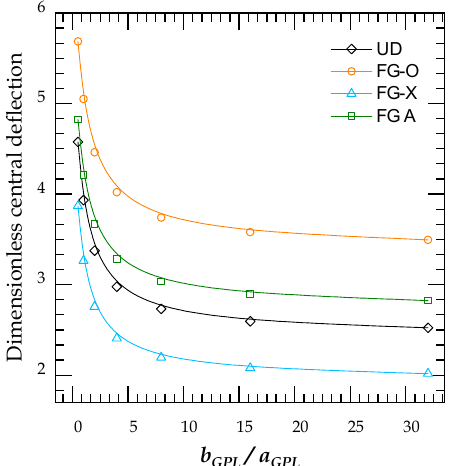
Figure 11. Dimensionless central deflection of simply supported GRNC plate versus the length-to- thickness ratio of the GPLs nanofillers (g ∗ = 1%) . Figure 12 depicts the dimensionless central deflection influenced by width-to-length ratio b GPL / a GPL . It can be observed that the width-to-length ratio has a significant effect on the dimensionless central deflection for values less than 15, where central deflection decreases. The results are almost constant for greater values of ratio ( ≥ 15 ) regardless of the GPL reinforcement pattern.